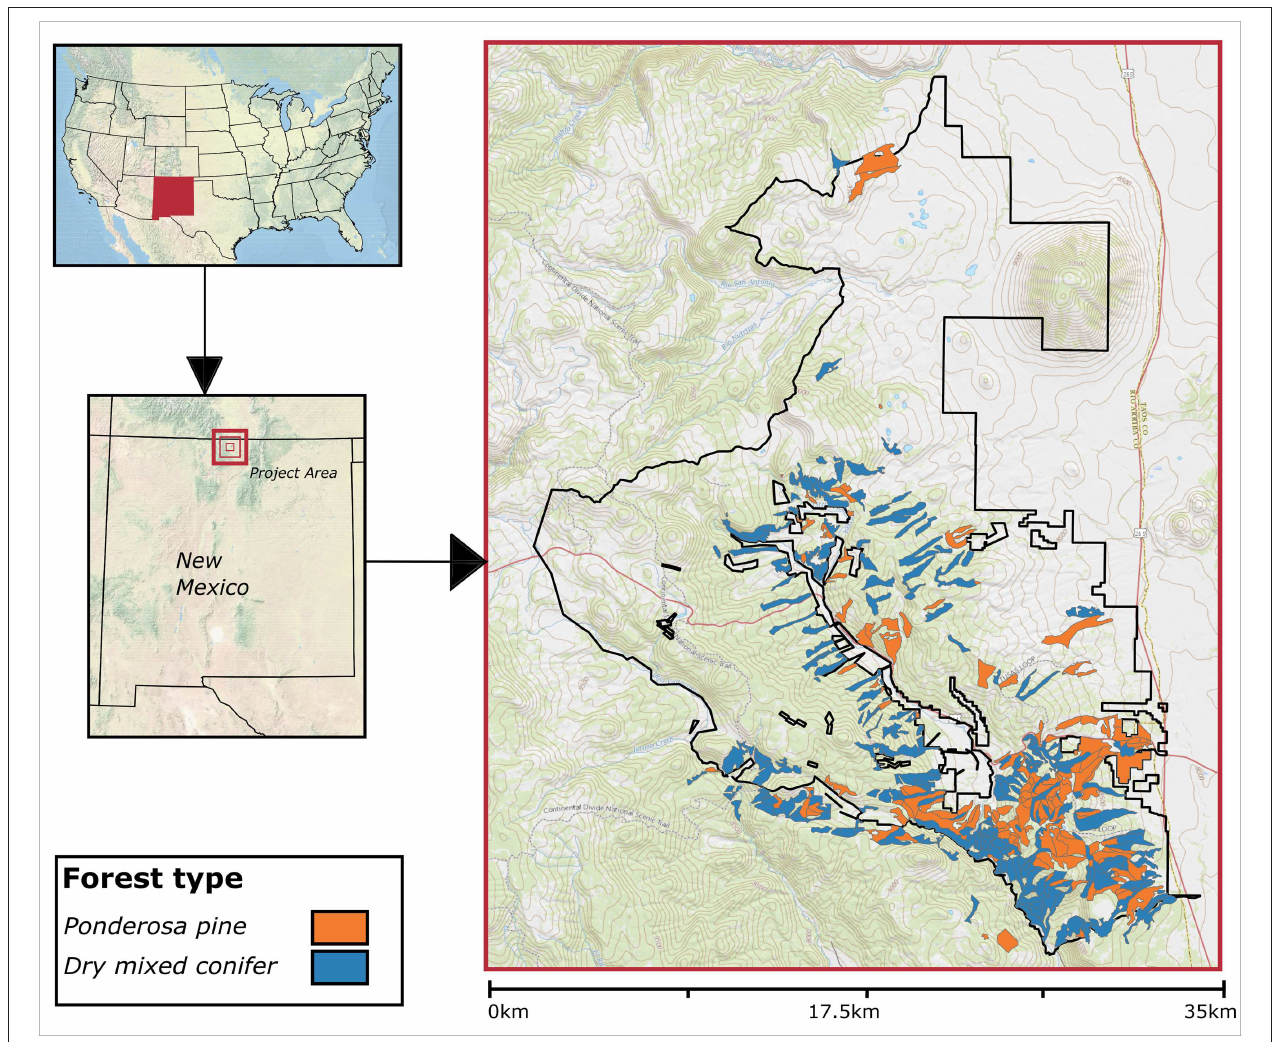
FIGURE 1 | The Rio Tusas-Lower San Antonio Landscape in Northern New Mexico with project area boundary outlined. Shaded polygons represent sampled stands and forest types overlaid on a digital elevation model (DEM).